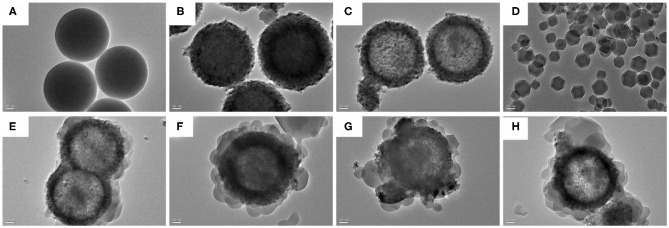
TEM images of (A) SiO2, (B) core-shell SiO2@TiO2 nanoparticles, (C) hollow TiO2 nanoparticles, (D) ZIF-8, (E) HTZ-1, (F), (G) HTZ-2, and (H) HTZ-3.